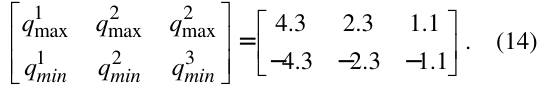
Figure 6. Maximum error norm